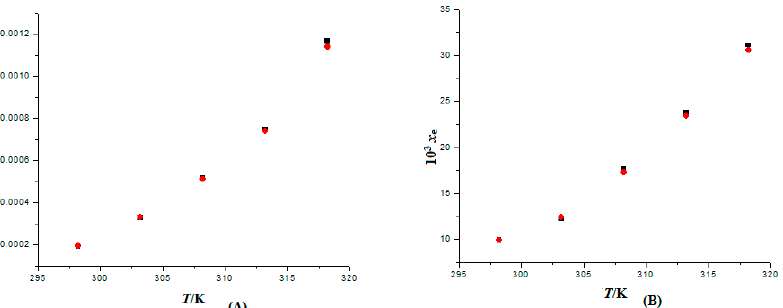
Materials 2022 , 15 , x FOR PEER REVIEW 8 of 16 Figure 3. Graphical comparison of FXT mole fraction solubility data in ( A ) neat H 2 O and ( B ) neat PEG 400 with those found in the literature at 298.2–318.2 K. The symbol denotes the measured mole fraction solubilities of FXT in ( A ) neat H 2 O and ( B ) neat PEG 400, and the symbol denotes the reported solubilities of FXT in ( A ) neat H 2 O and ( B ) neat PEG 400 taken from reference [32]. Table 3. Comparison of current solubility data of FTX in PEG 400 with different approaches of FXT solubility enhancement at 298.2